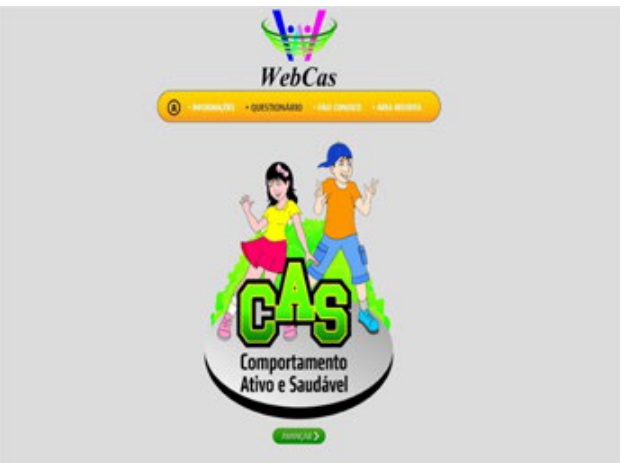
FIGURE 1- WebCas Electronic Questionnaire Home Screen FIGURE 2 - WebCas Registration Screen